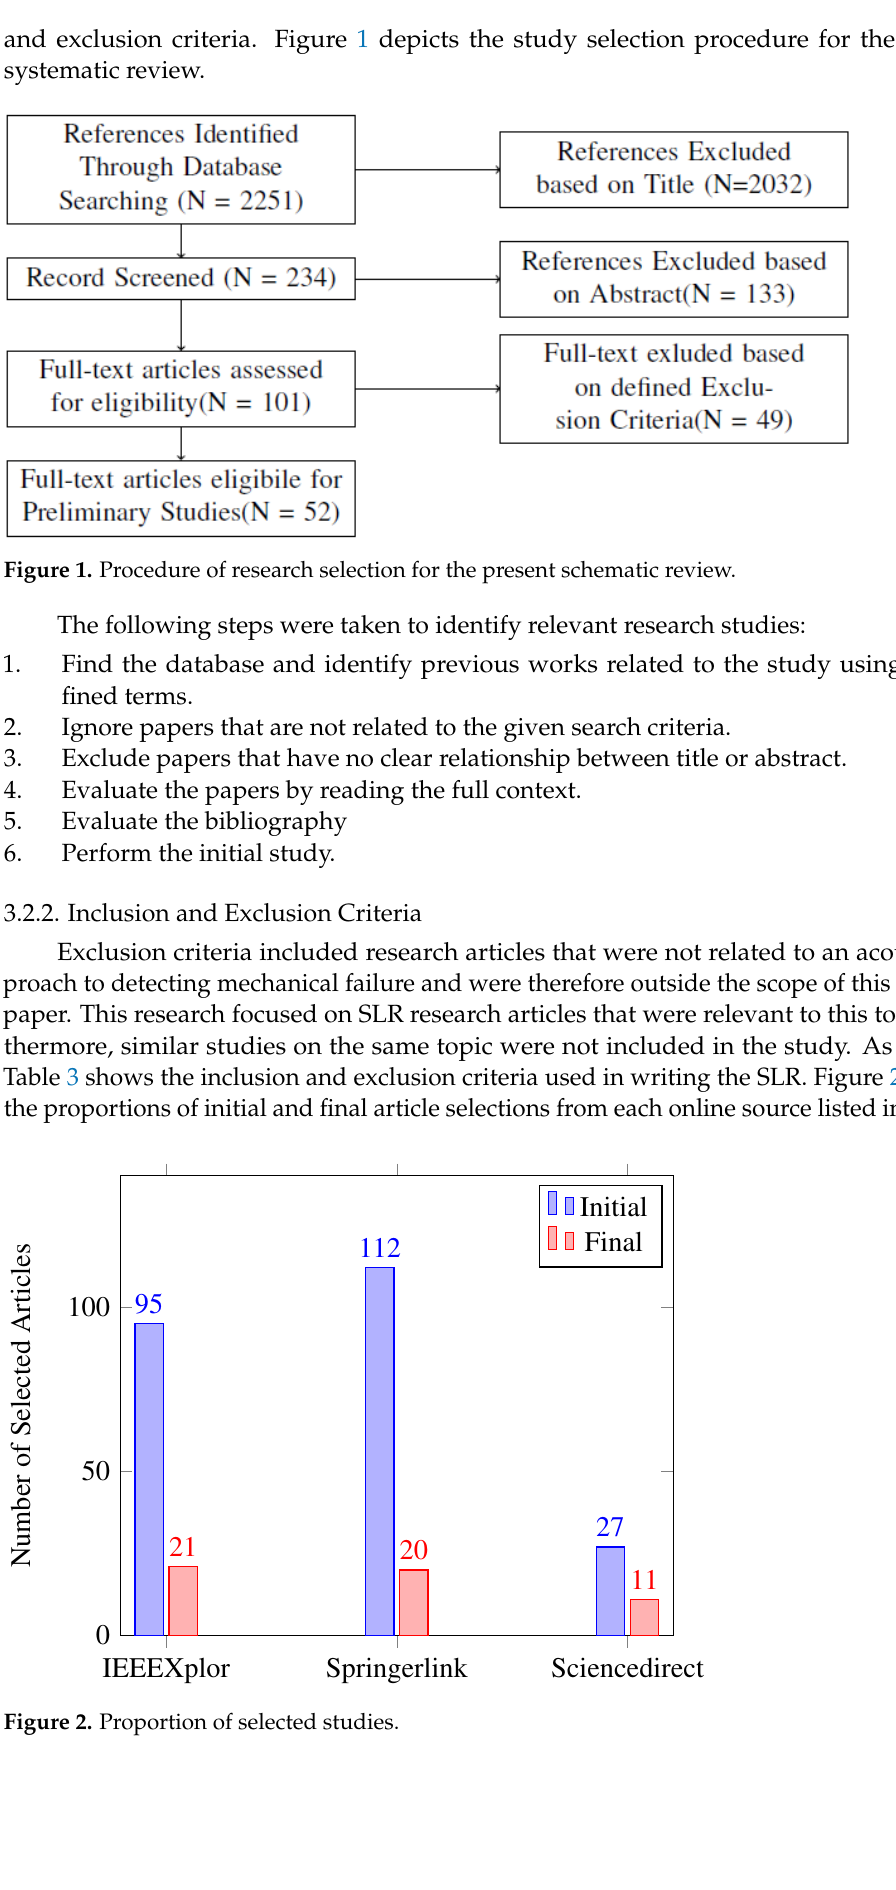
Figure 1. Procedure of research selection for the present schematic review